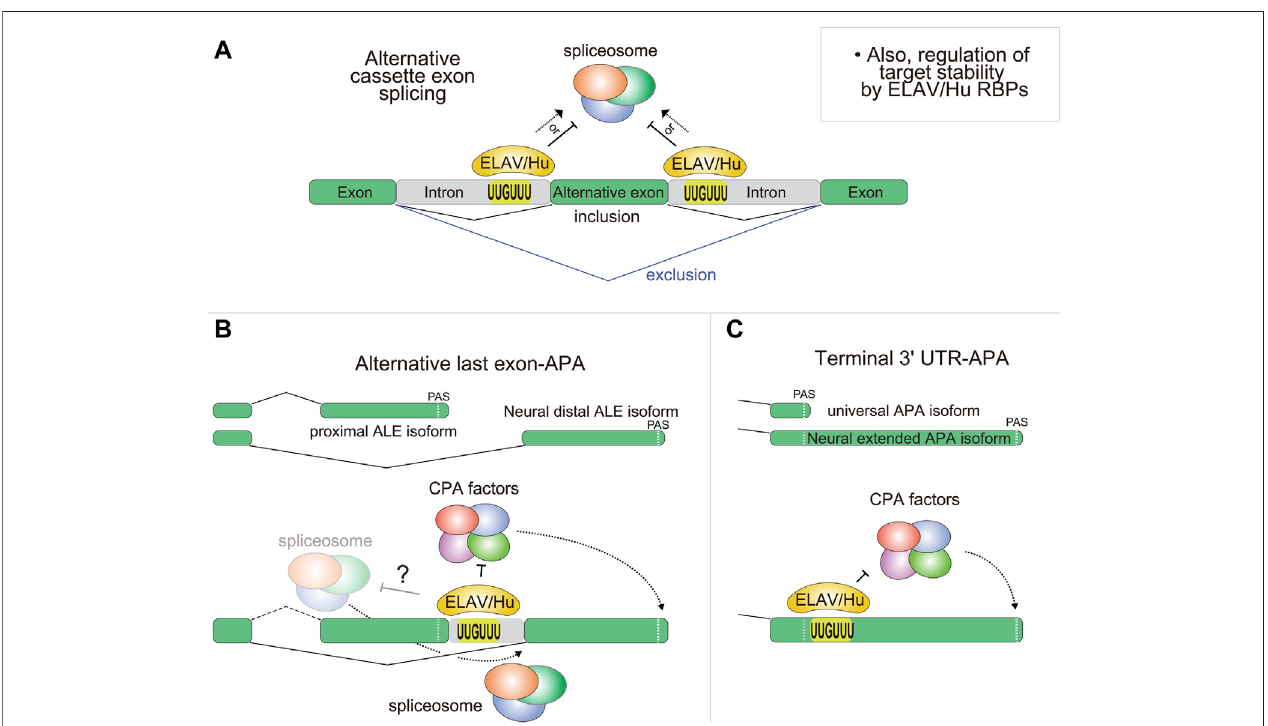
FIGURE 3 | Regulation of alternative splicing and 3 ’ UTRs by ELAV/Hu RBPs. This fi gure summarizes effects on mRNA isoform generation, but ELAV/Hu factors also affect target mRNA levels. (A) The genetic manipulation of both fl y and mammalian ELAV/Hu RBPs causes largescale changes in the expression of alternative internalsplicingisoforms,causingsomecassetteexonstobeincluded whileothersareexcluded.Presumably,thelocalbindingofELAV/HuRBPs fl ankingtheregulated exonsimpactsthespliceosomemachinery,butthedetailsthatcontroldifferentfunctionaloutcomesremaintobeunderstood.Itisalsopossiblethatsomechanges in alternative splicing observed upon manipulation of ELAV/Hu factors are indirect effects. (B) Drosophila ELAV/Hu RBPs globally shift the usage of proximal alternative